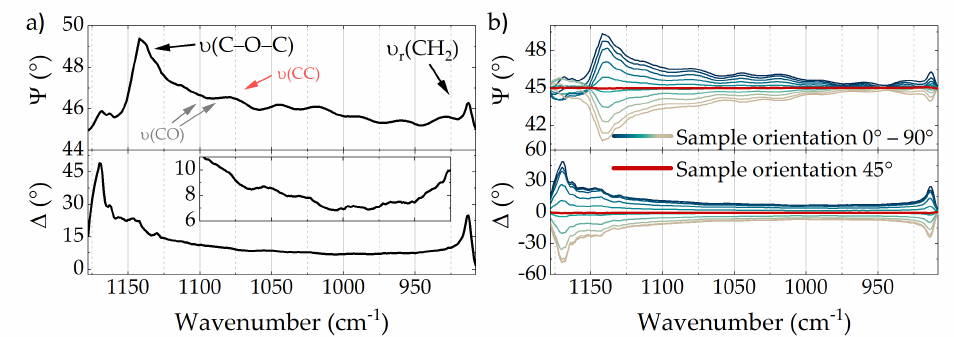
Figure 2. ( a ) ∆ , Ψ -spectra of a 116.5µm PE/EVOH/PE multilayer film recorded at normal incidence in transmission. The inset shows a magnification of the ∆ -spectrum in the respective spectral range. Band assignment for PE (red) and EVOH (black/grey) according to literature [45,46]. ( b ) Spectra of the multilayer film recorded at normal incidence and different sample rotation around the beam path in 887ms